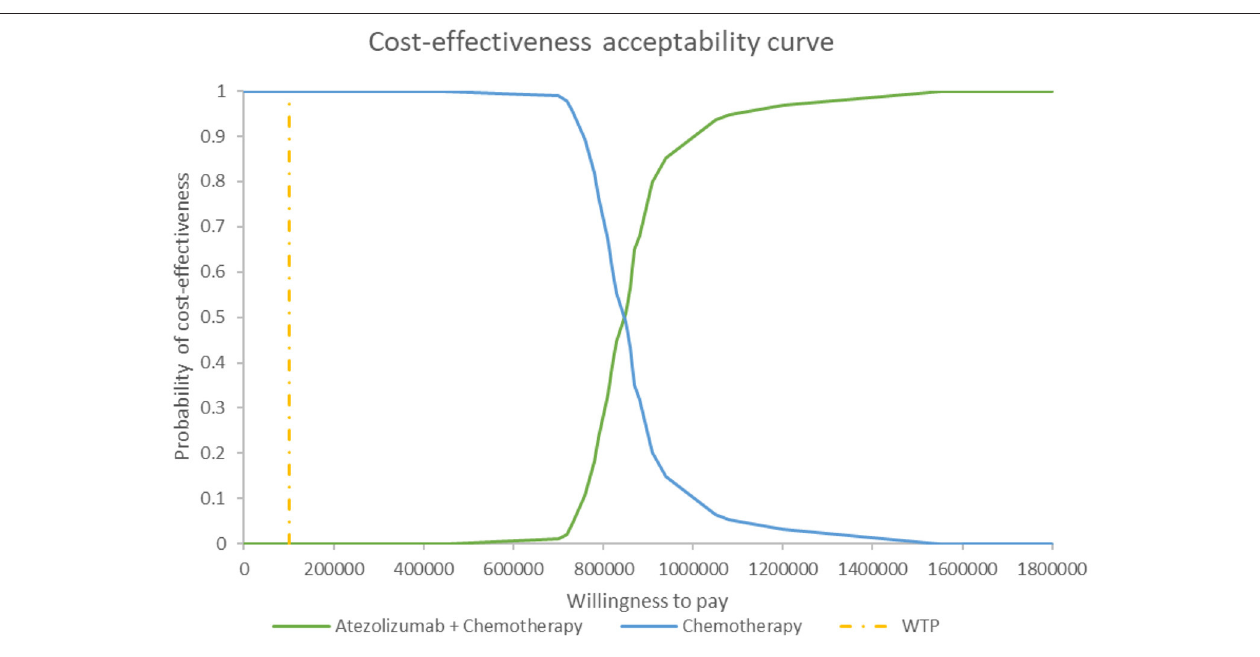
FIGURE 6 | Cost-effectiveness acceptability curve at different thresholds of willingness to pay in model 2. WTP, willingness to